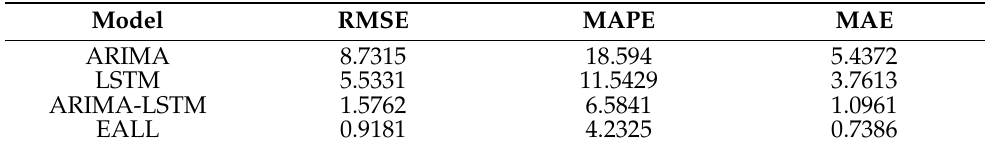
Table 3. Evaluation of prediction results of each model.